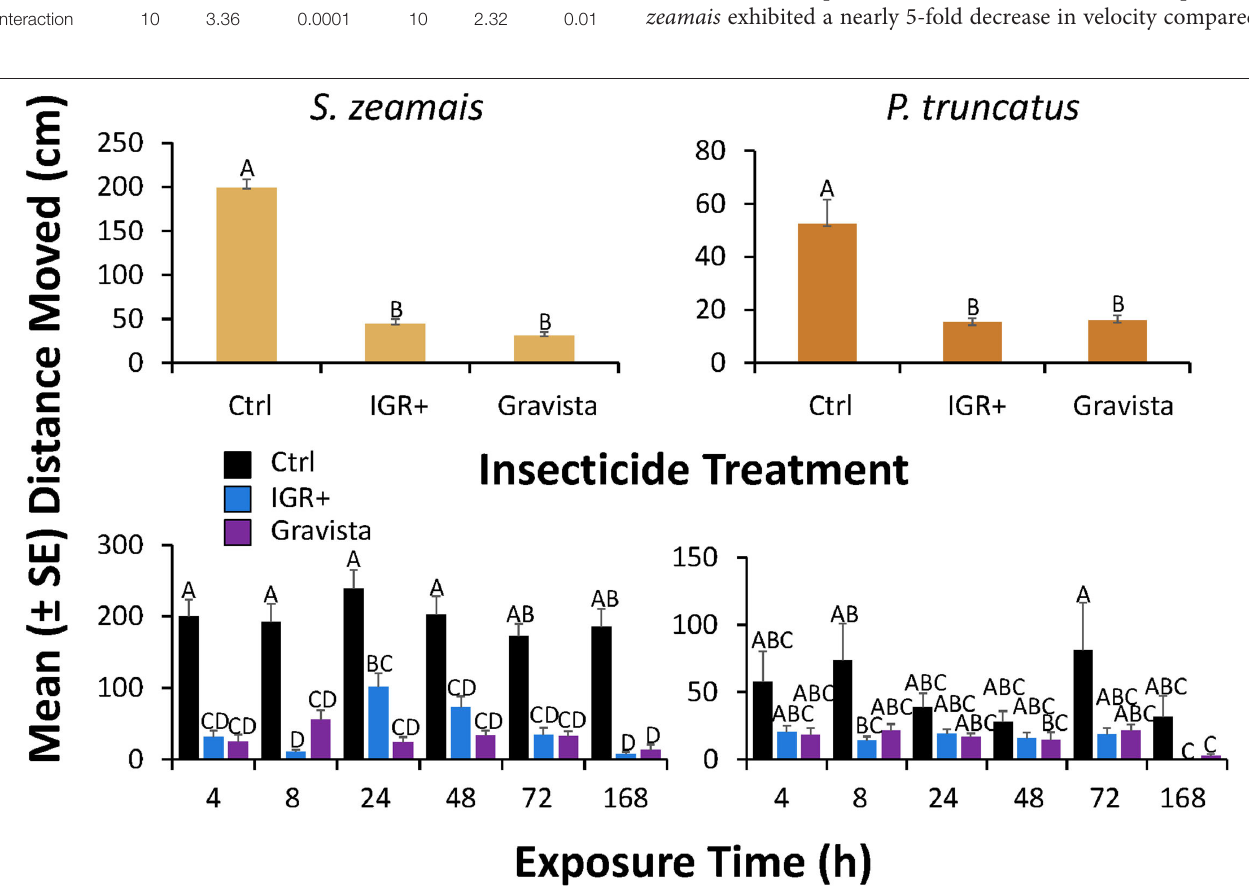
FIGURE 3 | Distance moved ( ± SE) by S. zeamais (left column) and P. truncatus (right column) after application of an existing (methoprene + deltamethrin, IGR + ) and novel (methoprene + deltamethrin + synergist, Gravista) commercial formulation of insecticide to concrete compared to a control overall (top panels) or broken down by exposure time (bottom panels) . Bars with shared letters are not significantly different from each other (Tukey HSD, α = 0.05).